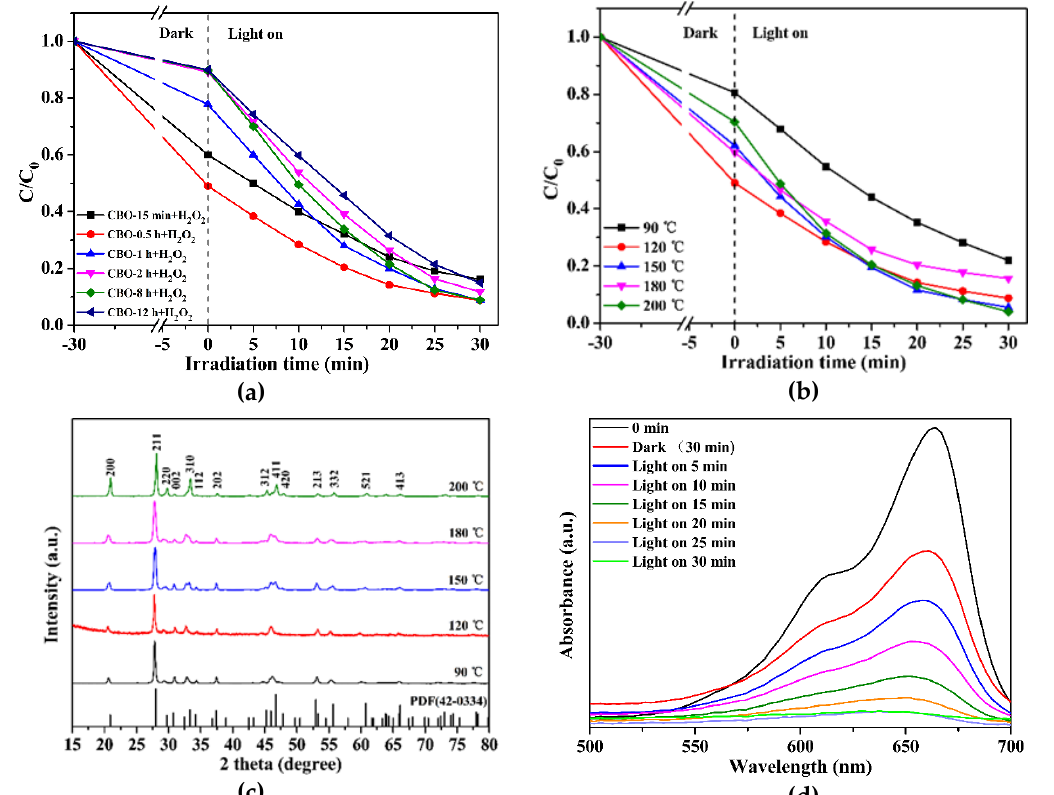
Figure 5. Photodegradation of methylene blue (MB) over as-prepared CuBi 2 O 4 ( a ) with different hydrothermal time and ( b ) treated under different hydrothermal temperature (90 °C, 120 °C, 150 °C, 180 °C, and 200 °C) with the presence of 0.05 mL H 2 O 2 under visible irradiation (λ ˃ 420 nm); ( c ) XRD patterns of CuBi 2 O 4 treated under different hydrothermal temperature; and ( d ) the UV-vis spectra of MB degradation in the presence of CBO-0.5 h..